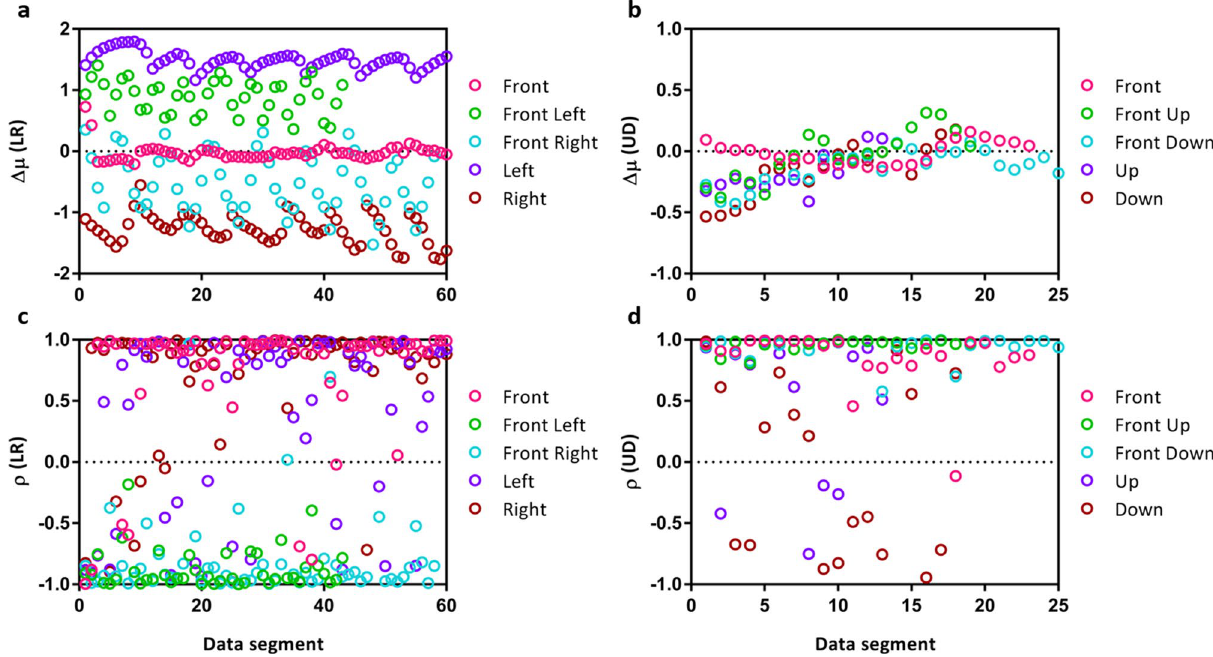
Figure 7. Extracted features ( a ) Difference in mean horizontal motion range ( b ) Difference in mean vertical motion range ( c ) Correlation coefficient horizontal motion range ( d ) Correlation coefficient vertical motion